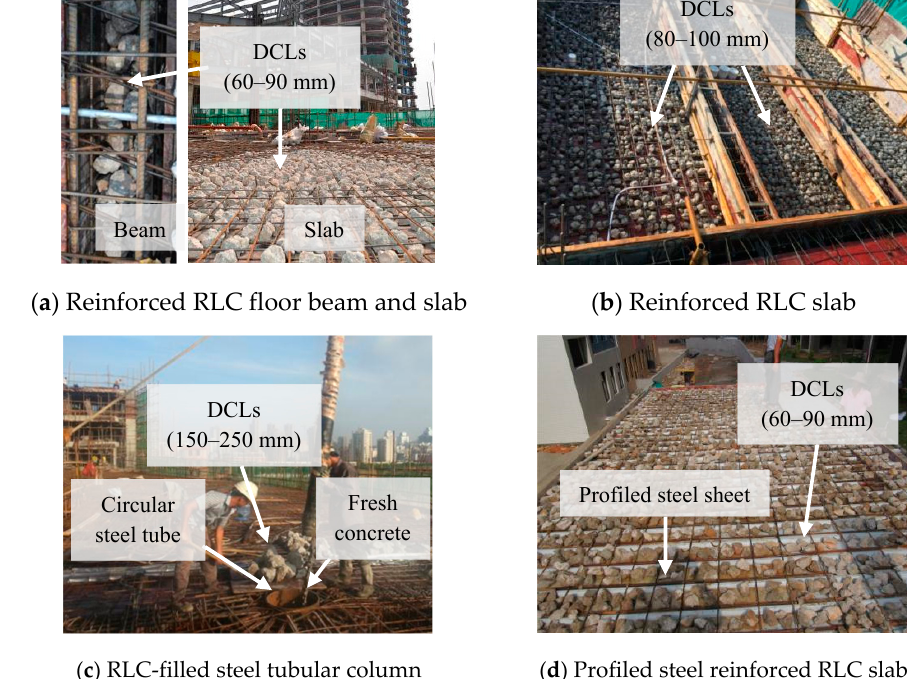
Figure 1. Examples of the application of recycled lump concrete (RLC) containing demolished concrete lumps (DCLs): ( a ) reinforced RLC floor beam and slab; ( b ) reinforced RLC slab; ( c ) RLC-filled steel tubular column; ( d ) profiled steel-reinforced RLC slab.